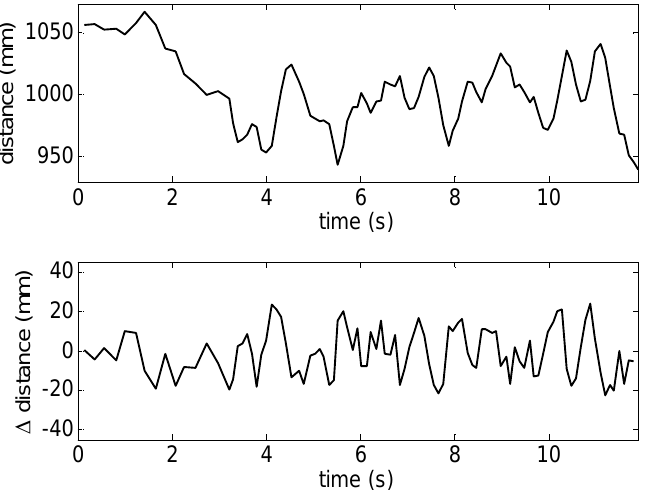
Figure 12. Distance user-frontal line obtained in the experiment of Figure 11.